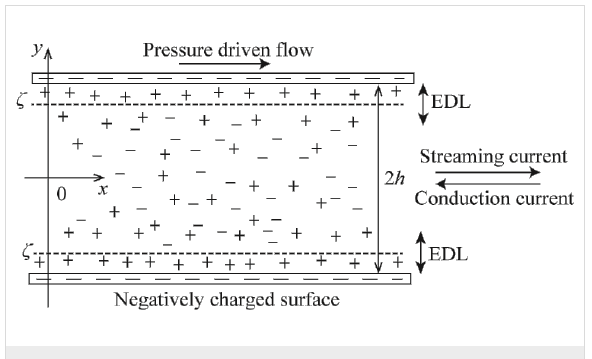
Figure 1: Schematic of the electroviscous effect in a microchannel formed by two infinitely large parallel plates with a distance of 2 h